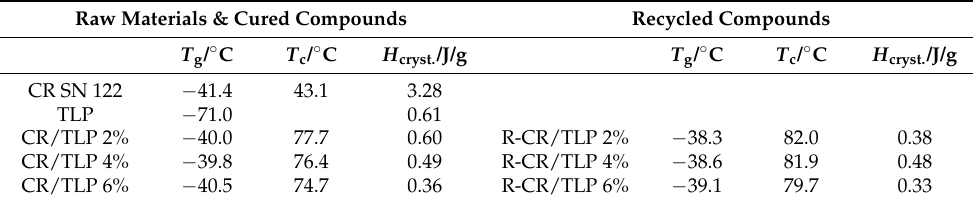
Table 6. T g , T c and enthalpy values of raw materials and cured compounds compared to recycled compounds.